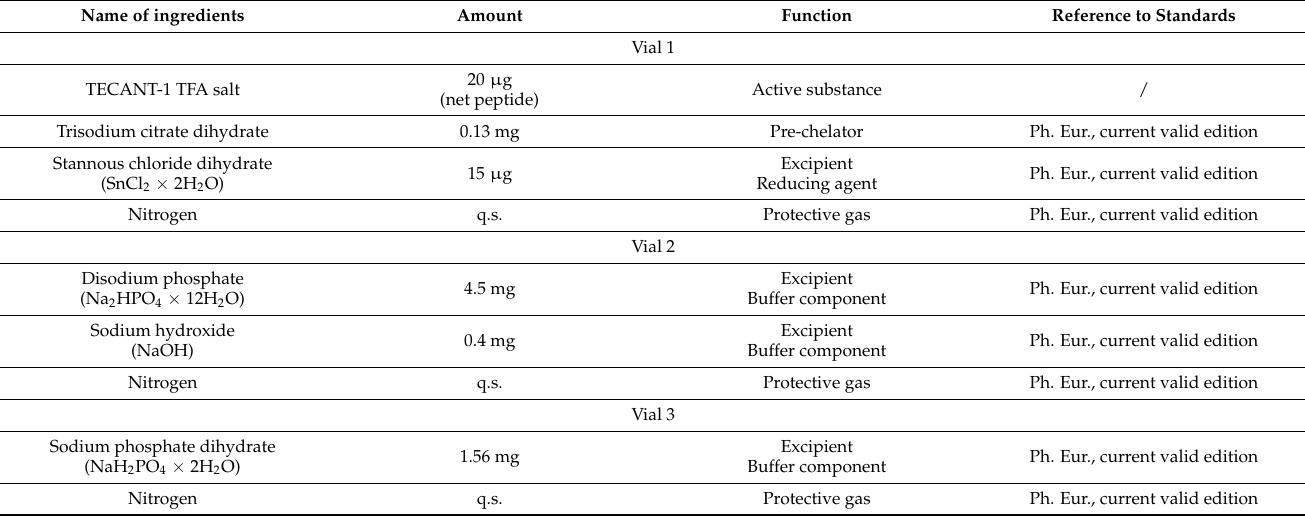
Table 5. Composition of the TECANT-1 kit for radiopharmaceutical